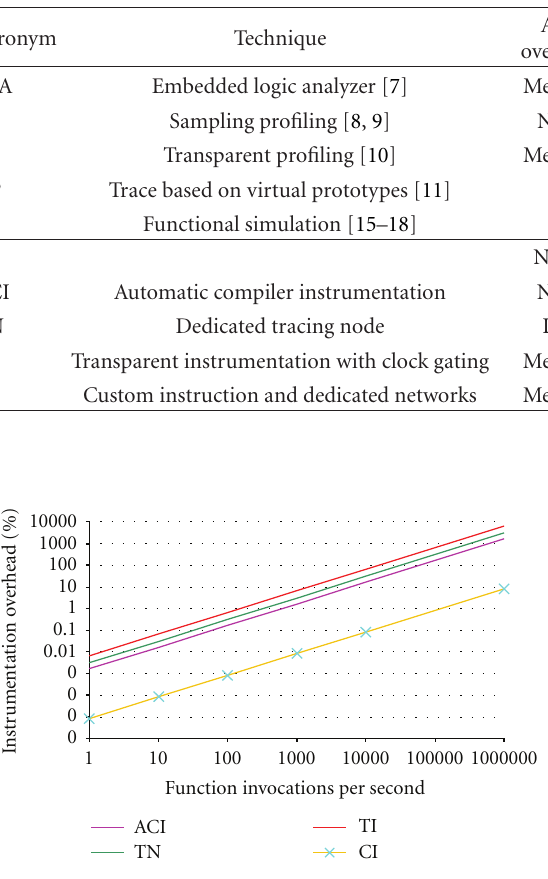
Table 3: Performance analysis methods that can be used in multi-soft-core and many-soft-core applications.